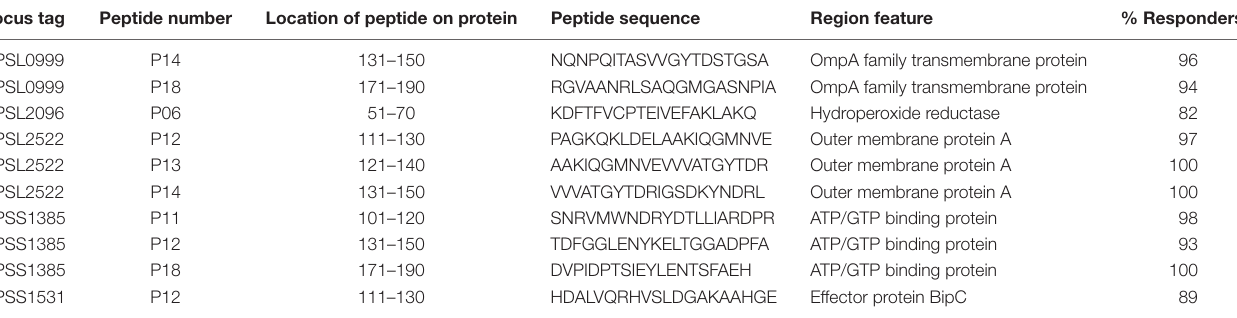
TaBle 2 | Selected 10 T-cell immunoprevalent peptides of Burkholderia pseudomallei (Bp) identified from seropositive healthy donors using 20 Bp libraries. locus tag Peptide